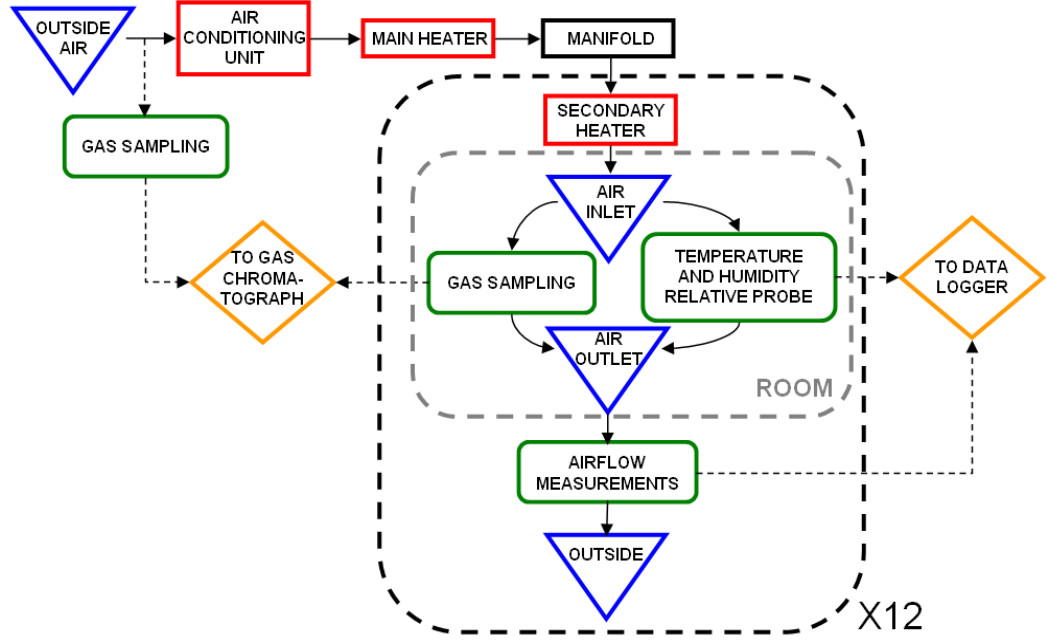
Figure 1. Schematic view of the air sampling in the